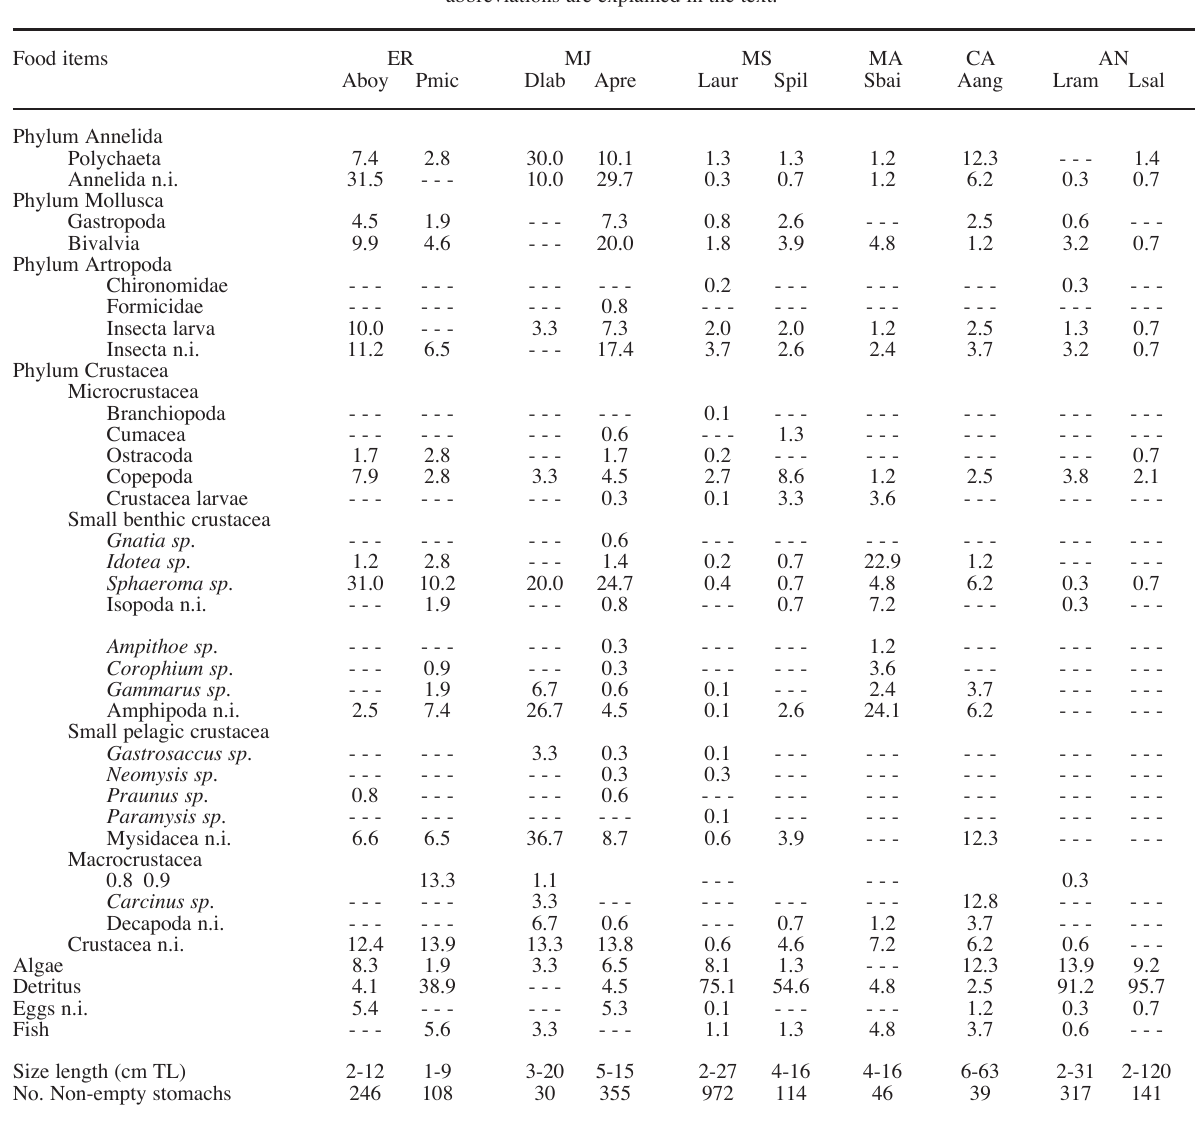
T ABLE 4. – Food items frequency of occurrence on abundant species during 1999. Species abbreviations are explained in Table 1, and guild abbreviations are explained in the text. Food items